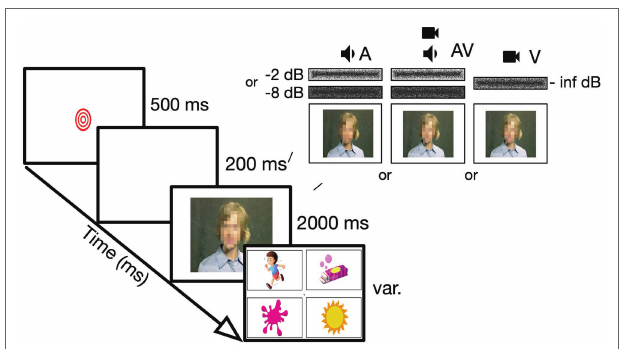
FIGURE 2 | Visualization of the AV Study Experimental set up of the AV Study in both laboratory and online. Audio-only, audiovisual, or visual-only stimulus presentation of one-syllable words in speech-weighted noise, followed by a 4AFC answer screen (Gijbels et al., in